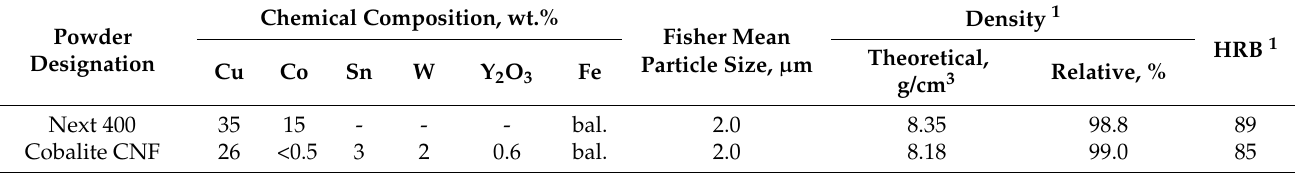
Table 1. Main properties of two powders designed for production of diamond tools by pressure-less sintering [7,12,13]. Powder